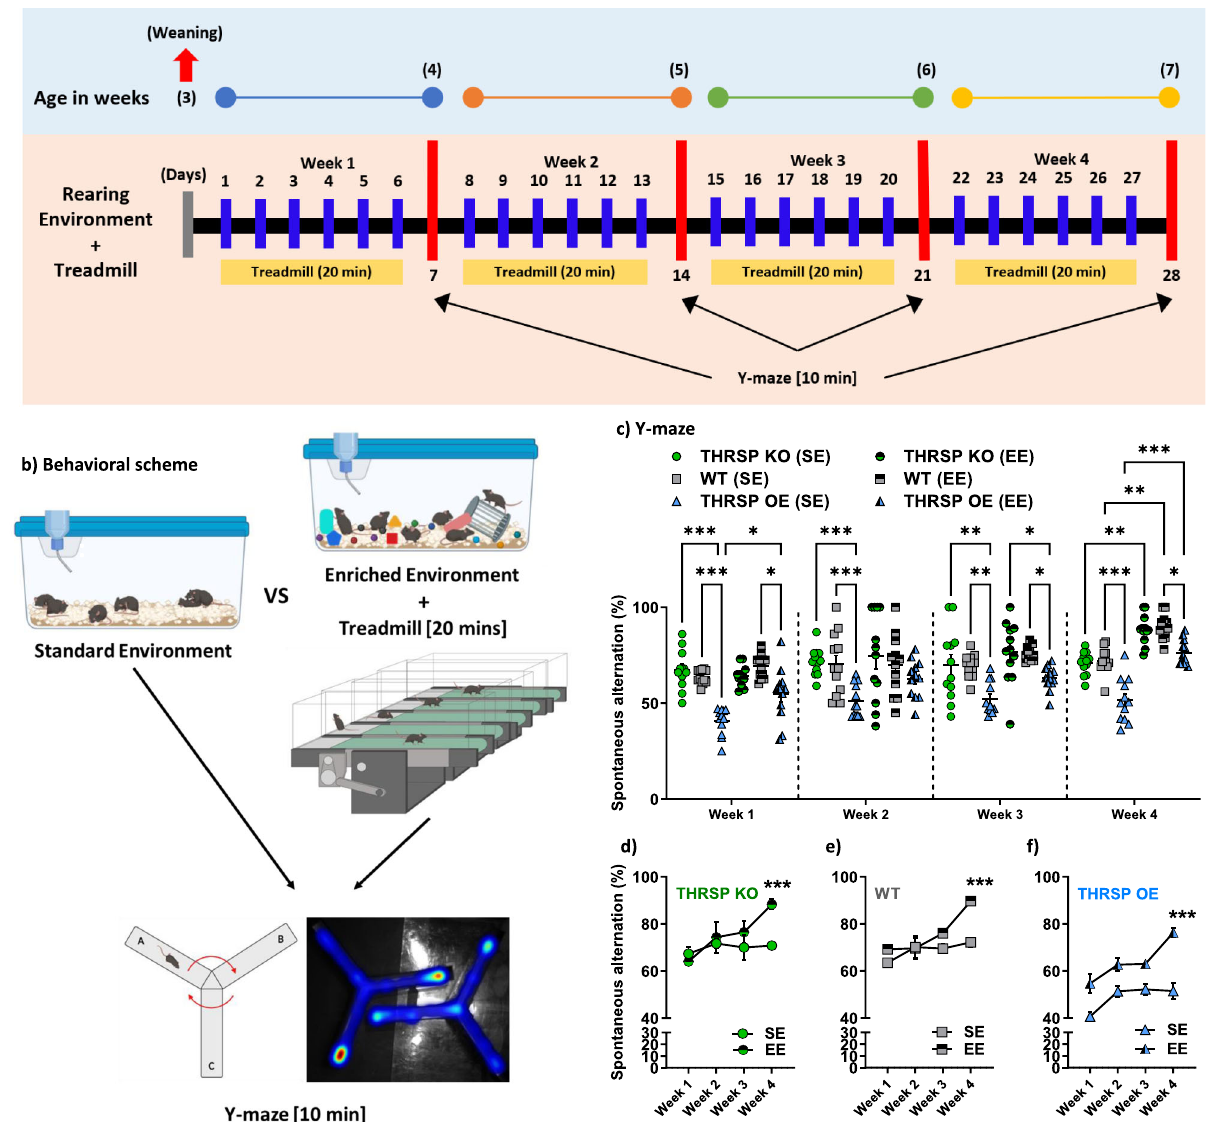
Fig. 7 Effects of combined environmental enrichment and treadmill exercises on the ADHD-PI-like behavior in THRSP OE mice. a Experimental schedule showing age in weeks and the commencement of rearing environment + treadmill exercises in mice. b Behavioral scheme showing the representative image, with cages where mice were exposed (standard vs. enriched environment), treadmill, and representative Y-maze heatmap image. c , d The behavior of mice exposed to SE and EE throughout the 4-week exposure to rearing environment + treadmill exercises. ( n = 12 mice/group; c one-way ANOVA, F ( 5, 18 ) = 7.62, P < 0.001); d two-way ANOVA (THRSP KO), Weeks: F ( 1, 22 ) = 6.32, P = 0.020; SE/EE exposure per strain: F